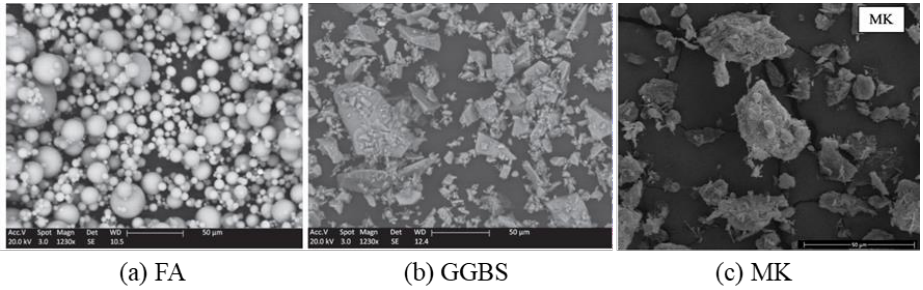
Figure 2. Scanning electron microscope (SEM) images for ( a ) fly ash (FA), ( b ) granulated blast furnace slag (GGBS) [16], and ( c ) metakaolin (MK) [17].